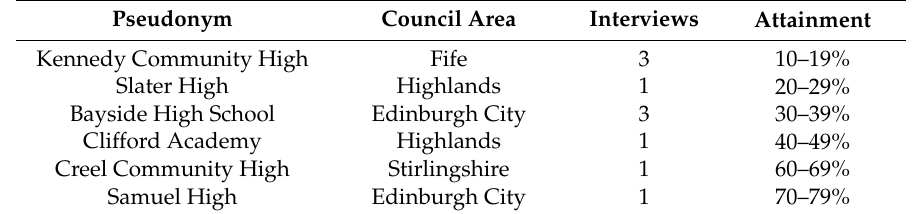
Table 1. Schools interviewed (attainment is the number of pupils with 3+ level 6 awards in